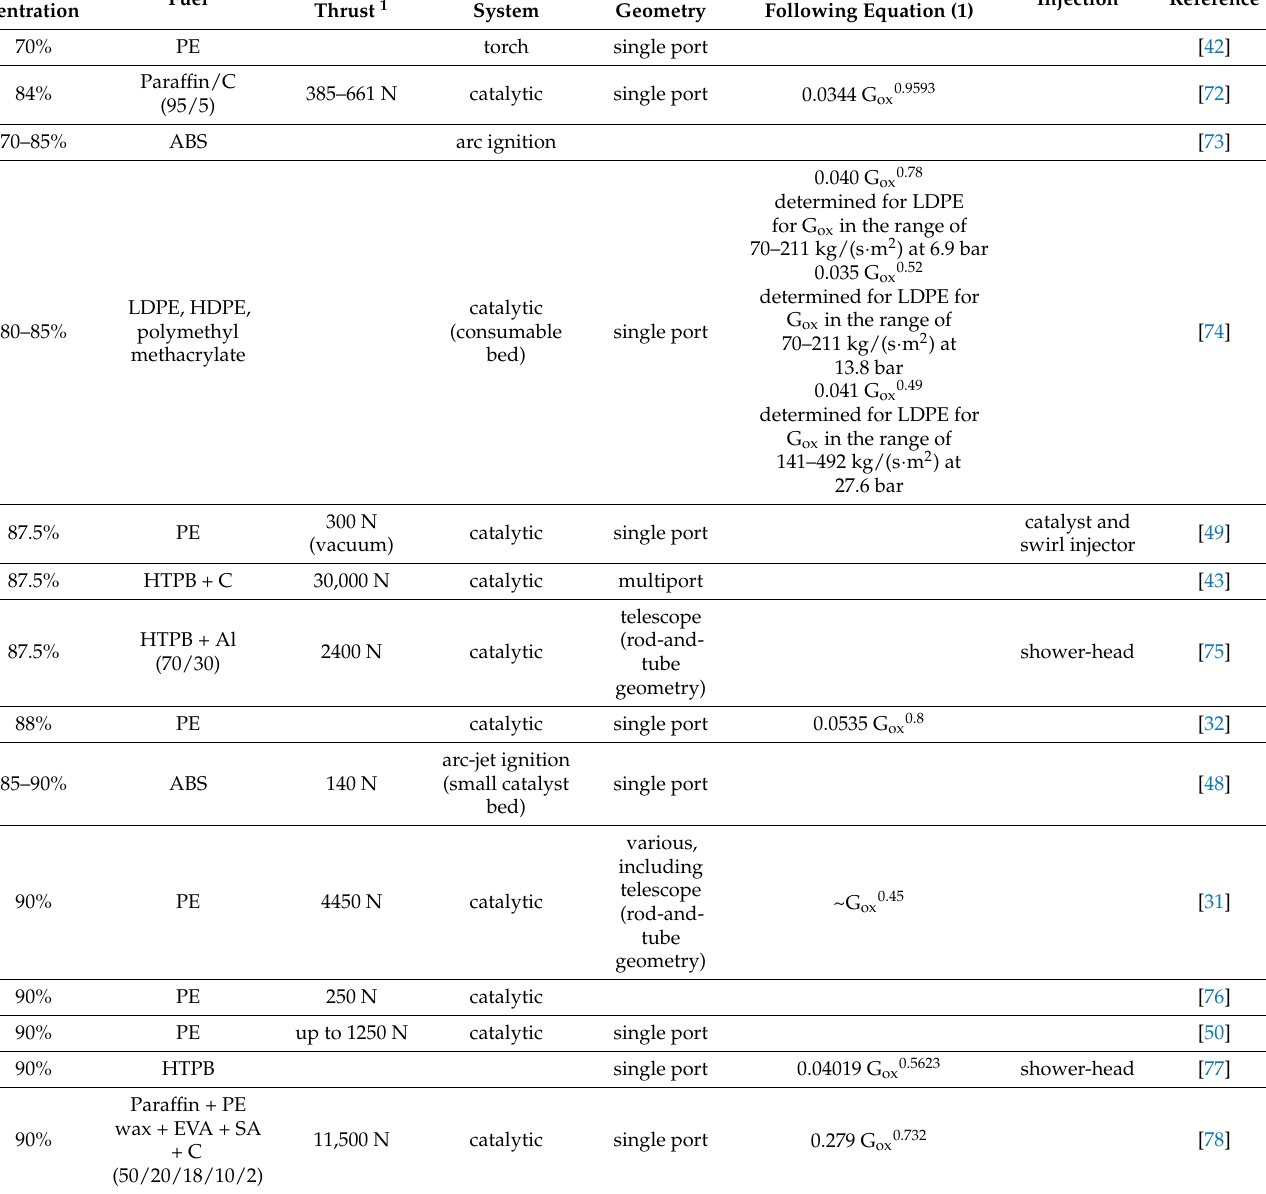
Table 1. Summary of literature review of hybrid propulsion research using HTP as oxidizer. H 2 O 2 Con-